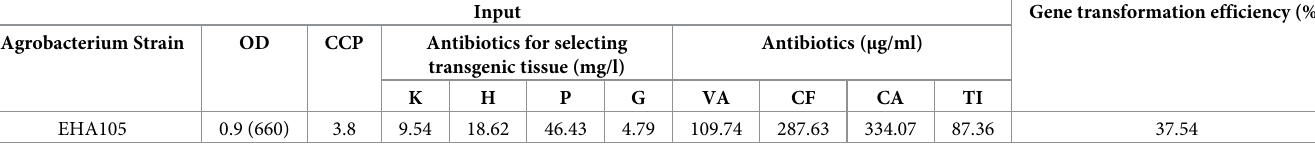
Table 2. The results of optimization process via FOA for gene transformation efficiency of chrysanthemum. Input Gene transformation efficiency